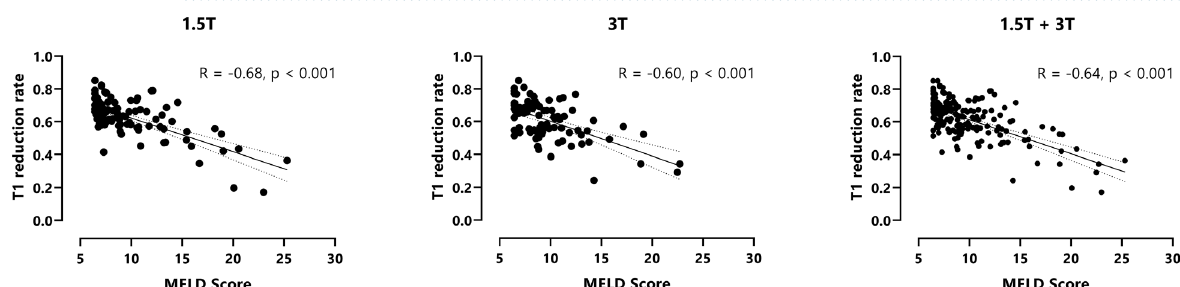
Figure 3. Pearson correlation between T1 reduction rate and Child–Pugh score. T1 reduction rates are shown for patients with liver cirrhosis at 1.5 T ( A ), at 3 T ( B ) and for pooled 1.5 + 3 T data ( C ). A reduced T1 reduction rate correlated moderately with a higher Child–Pugh score (R = − 0.60 at 1.5 T, R = − 0.66 at 3 T and R = − 0.63 for pooled data).